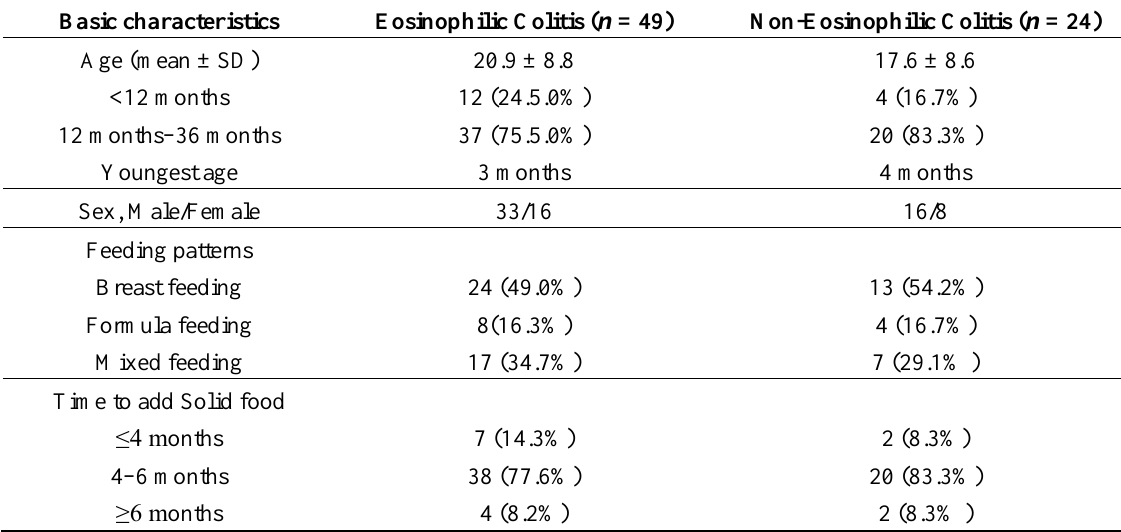
Table 2. Patient basic characteristics in infants and children with or without eosinophilic